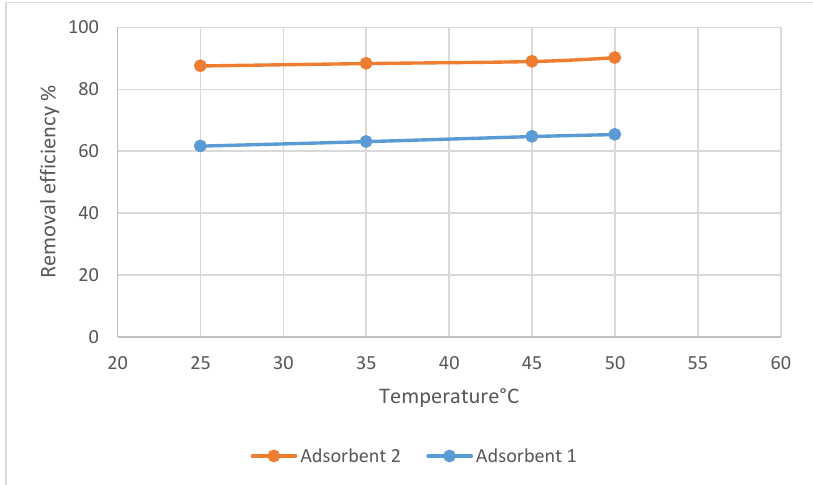
Figure 17. Effect of the temperature on Pb (II) ion adsorbtion (mean ± RSD) on adsorbent 1 and adsorbent 2 . (pH 6.5 ± 0.2, initial metal concentration = 20 mg/L Pb(II), dosage = 50 mg/50 mL, at different temperatures for 60 min). Each measurement has been done in triplicate.